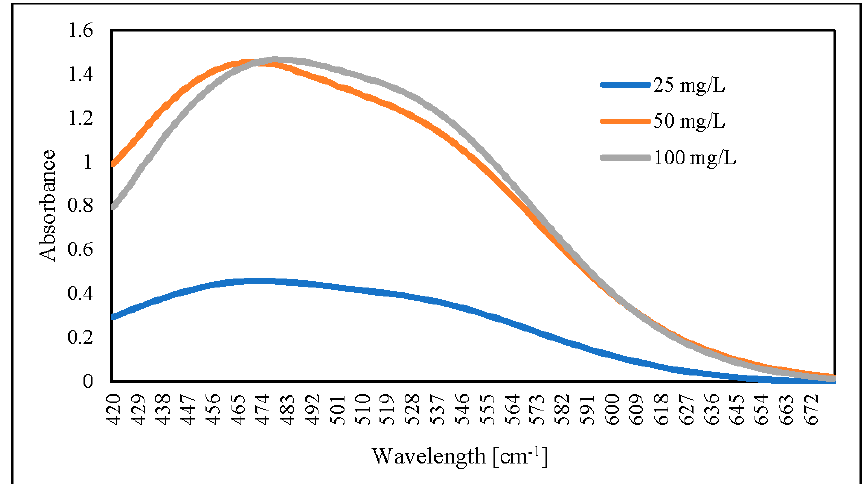
Figure 13. UV-visible spectra of AR88 dye hydrogel released by using 0.1 M NaOH (5 mg/20 mL, initial dye (AR88): 25, 50 and 100 mg/L; initial NO 3 : 100 mg/L; contact time: 60 min).